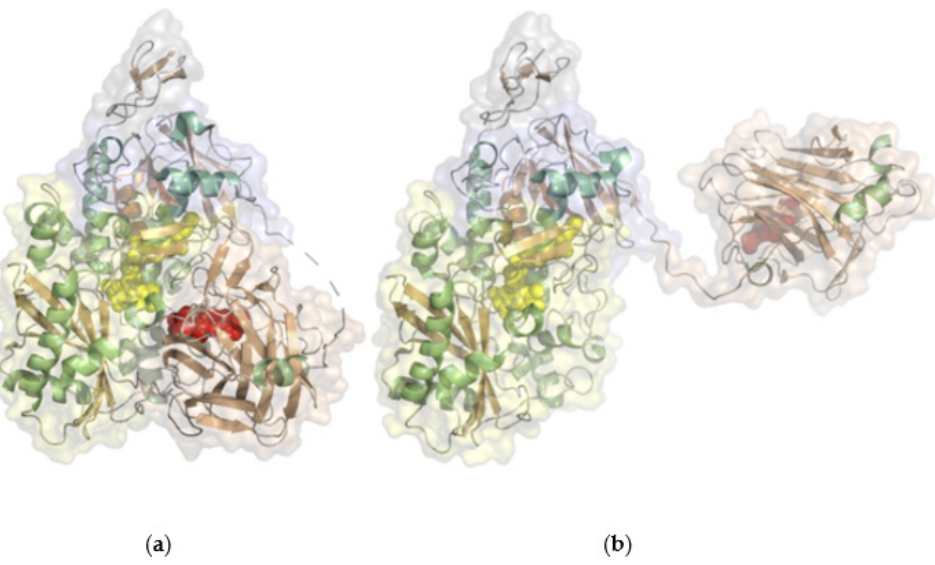
Figure 10. Crystal structure of ( a ) Crassicarpon hotsonii cellobiose dehydrogenase in closed conformation (PDB: 4QI6) and ( b ) Neurospora crassa cellobiose dehydrogenase in open conformation (PDB: 4QI7) with the FAD cofactor (yellow spheres) buried inside the protein shell. The FAD-binding- and substrate-binding subunits are colored light blue and light yellow, respectively. The GMC-oxidoreductase family characteristic dinucleotide binding βαβ -motif (Rossmann-fold) is highlighted in orange. A C-terminal type 1 carbohydrate binding module (CBM_1) is shown “on top” of the structure. The DET-competent cytochrome domain (light red) with the surface exposed heme b cofactor (red spheres) accepts electrons from substrate oxidation from the FAD in the closed conformation and donates them to suitable acceptors in the open conformation.